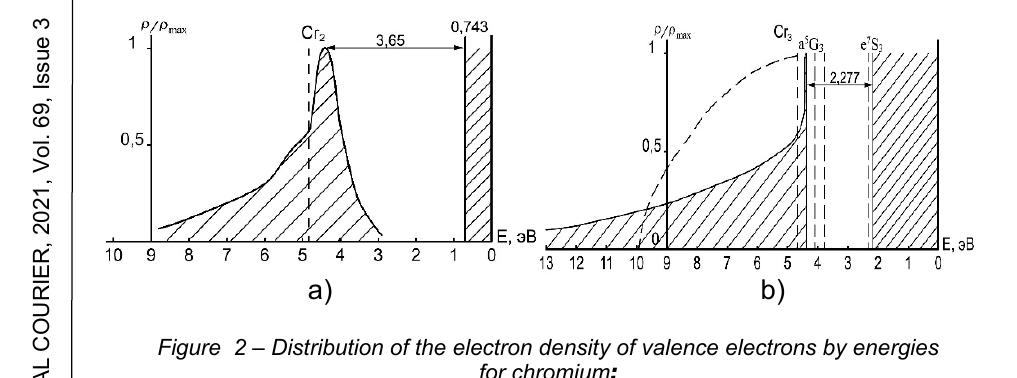
а ) b) Figure 2 – Distribution of the electron density of valence electrons by energies for chromium